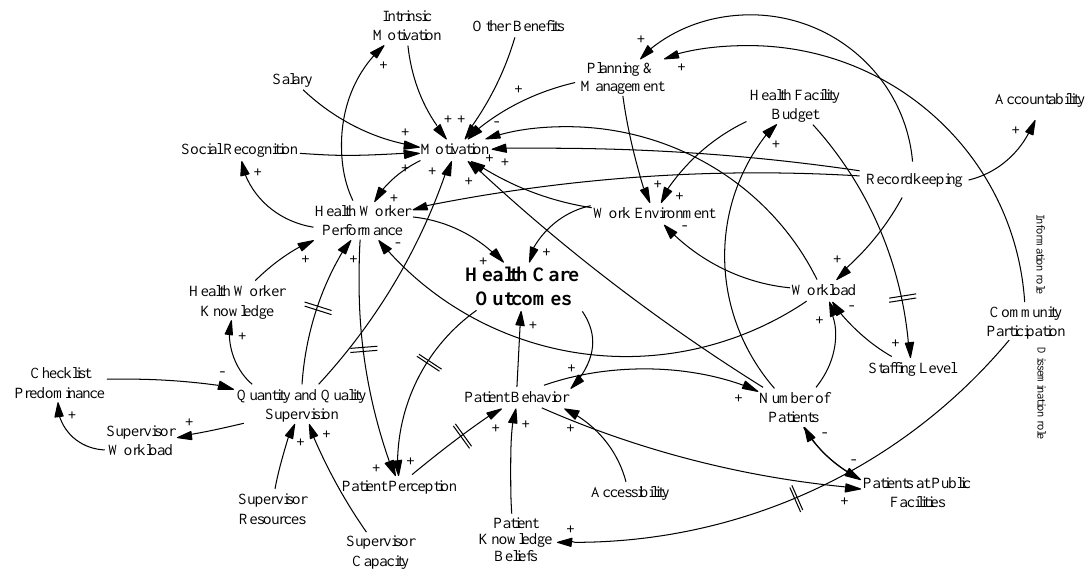
Figure 3. Causal loop diagram as perceived by the health workers.